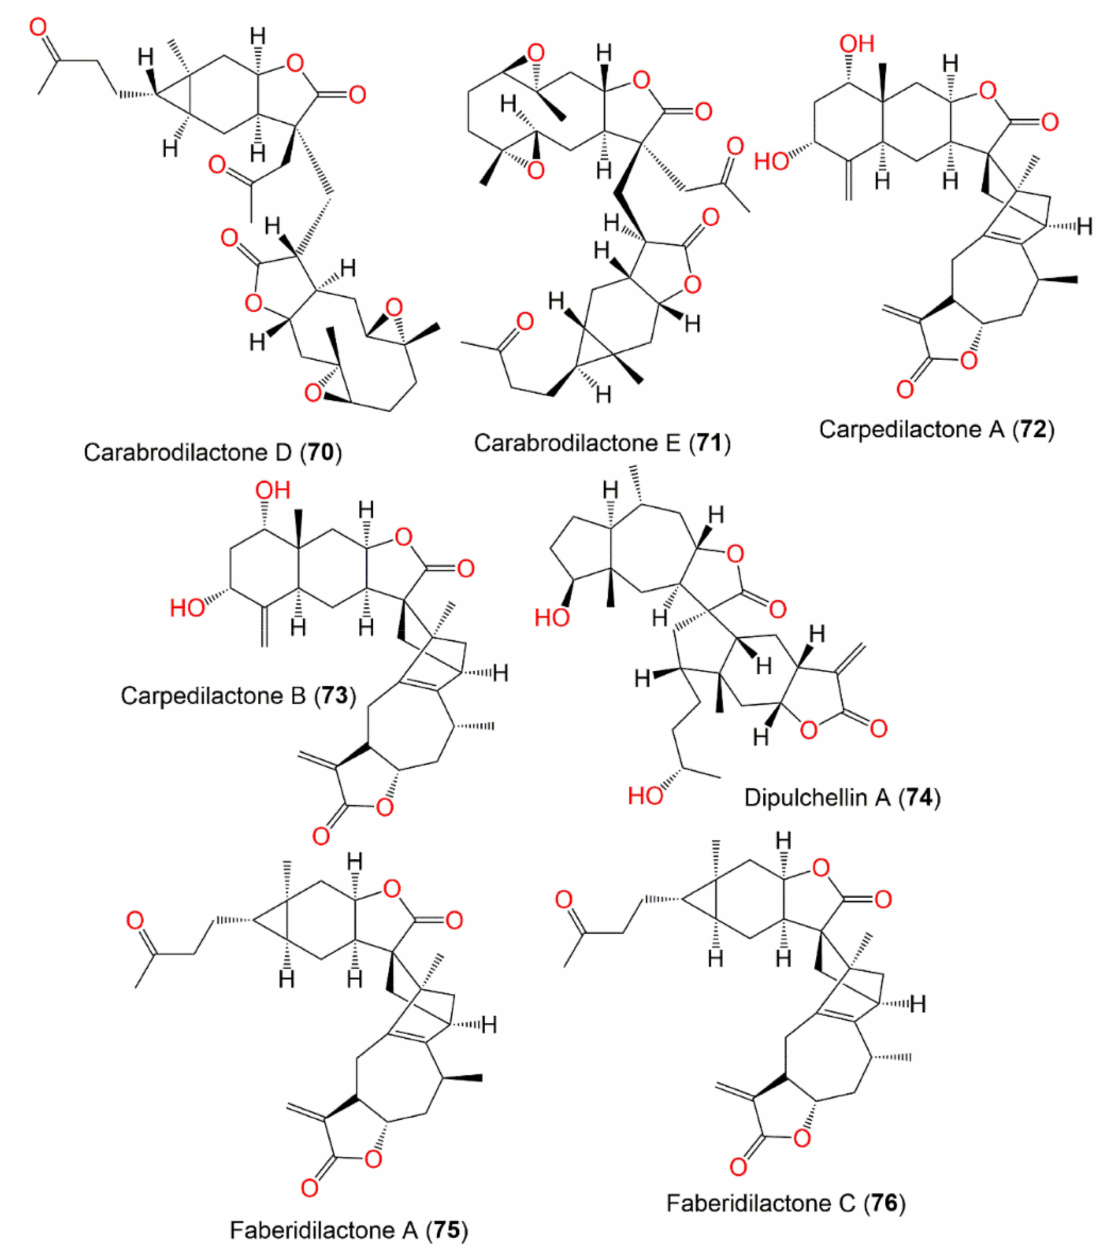
Figure 12. Structures of dimeric sesquiterpenes ( 70 – 76 ) reported from C. abrotanoides . It was proposed that Dipulchellin A ( 74 ) be biosynthesized from [3+2] cycloaddition as reported in 64 and 65 C-5 (cid:48) -C4 (cid:48) bond. The cyclopentane ring possibly originated from a [3+2] cycloaddition of a cyclopropane ring of carabrone ( 55 ) monomer and the double bond of 2-desoxy-4-epi-pulchellin ( 31 ) (Scheme 8) via radical intermediates. The C-5 (cid:48) - C-1 (cid:48) bond is cleaved to form a radical intermediate, and the C-5 (cid:48) radical is then trapped with the double bond. Due to steric hindrance in the structure, C-1 (cid:48) forms a new bond with C-13 first, and subsequently C-5 (cid:48) forms another bond with C-11. Thus, a cyclopentane ring is introduced to link the two monomers